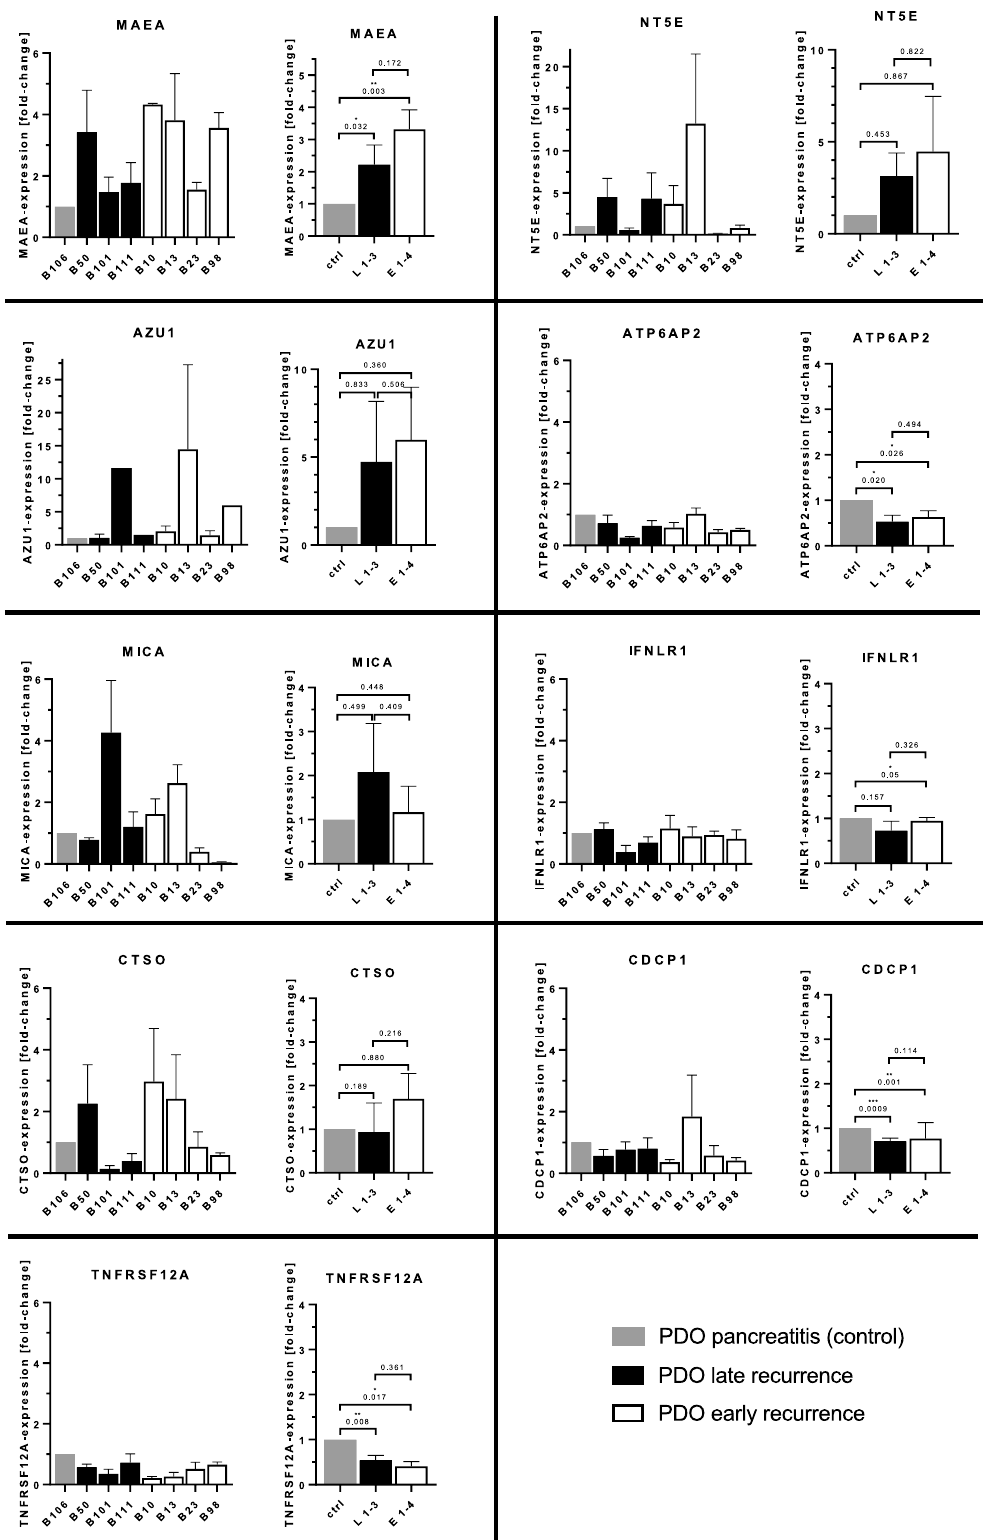
Figure 3. Gene expression analysis of patient-derived PDAC organoid cultures. The mRNA levels in seven organoid cultures (late recurrence: L1, L2, L3/early recurrence: E1, E2, E3, E4) were determined by qPCR for the genes MAEA, NT5E, AZU1, ATP6AP2, MICA, IFNLR1, CTSO, CDCP1 and TNFRSF12A. A ductal organoid line from a chronic pancreatitis patient (ctrl) served as control. The expression level of each gene was normalized against β-actin. Data is presented as mean ± SEM (n = 3), except AZU1 for E4, L2, L3 (n = 1). For each gene of interest, graphs on the left depict results for individual organoid lines, and graphs on the right a merged analysis including statistics. Statistical evaluation was performed using Student’s t-test: *p < 0.05; **p < 0.01; ***p <